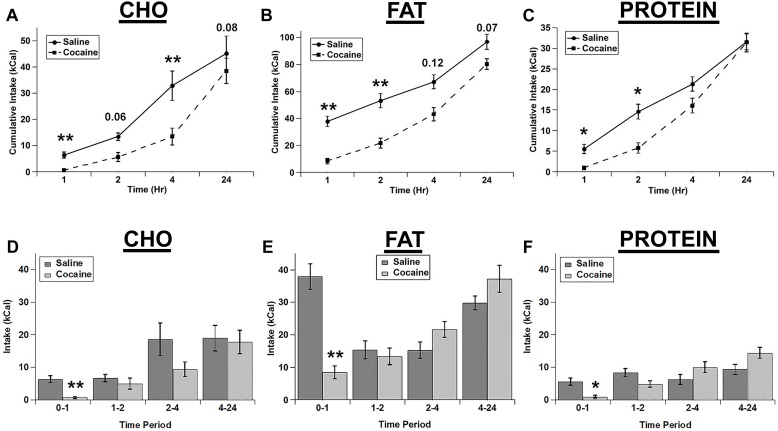
Cocaine inhibited all three test diets to a similar extent. Cumulative intake of the carbohydrate (CHO; A), fat (B), and protein (C) diets after saline and cocaine injection. Test diet intake during each individual time period (Non-cumulative) of the carbohydrate (D), fat (E), and protein (F) diets after saline and cocaine injection. Note the differences in the scale of the Y-axis for panels A–C. n = 7–12. *p < 0.05; ∗∗p < 0.01.